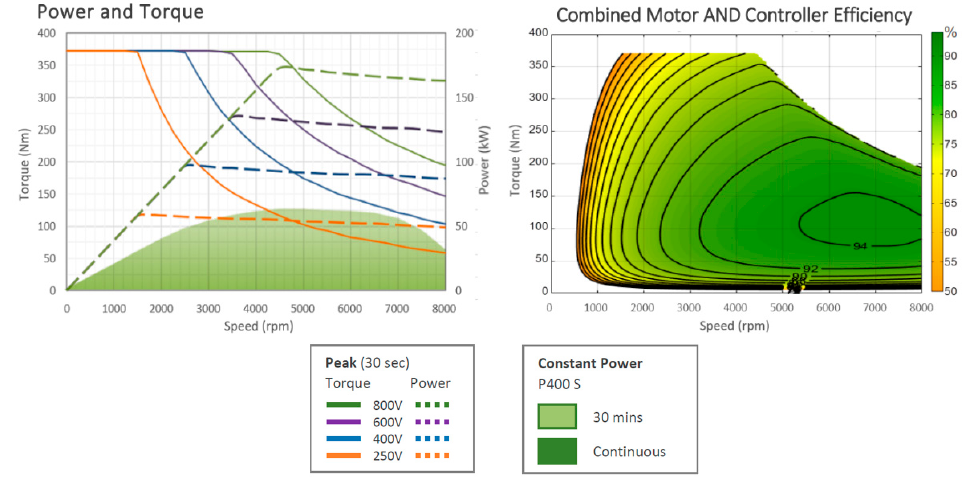
Figure 4. Power and torque curves of YASA P400 R on the left, efficiency map on the right. The specified performance is based on dynamometer test data. Peak ratings at rotor temperatures lower than 65 °C and coolant inlet temperatures lower than 65 °C with a coolant flow rate of 20 ltrs/min. Continuous ratings at coolant inlet temperatures lower than 50 °C with a coolant flow rate of 20 ltrs/min, ambient temperature lower than 30 °C.